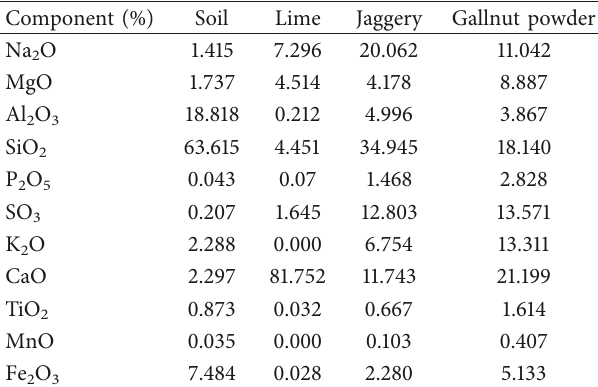
Table 2: Chemical composition of